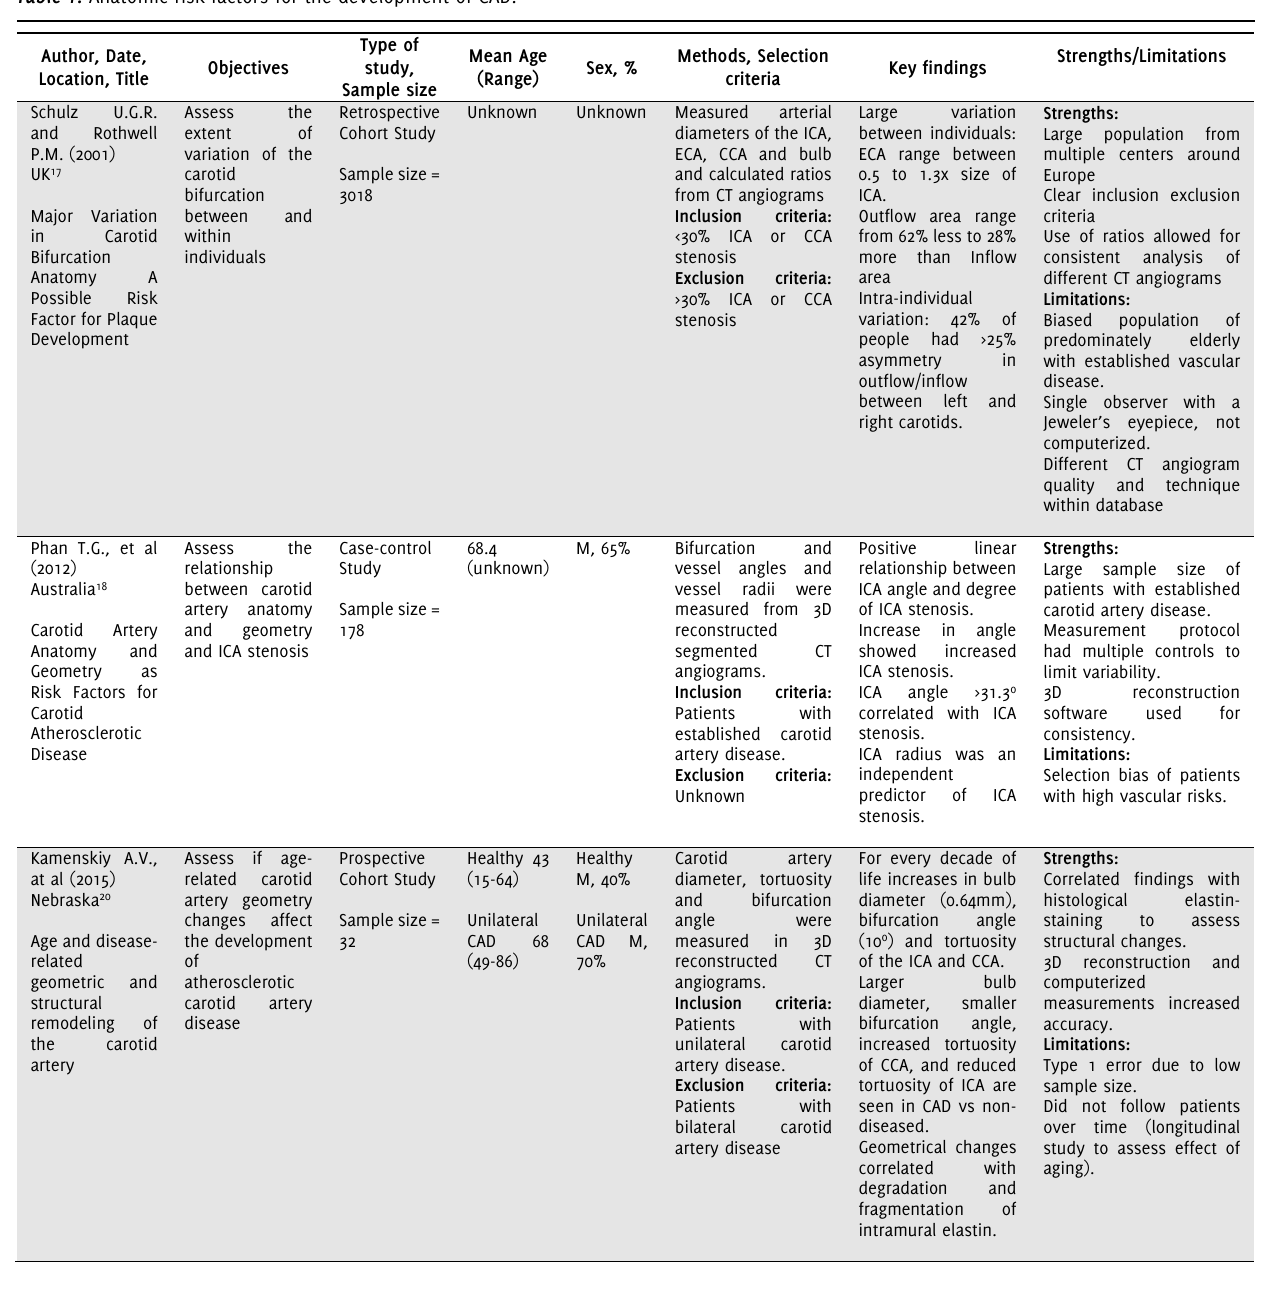
Table 1 . Anatomic risk factors for the development of CAD.